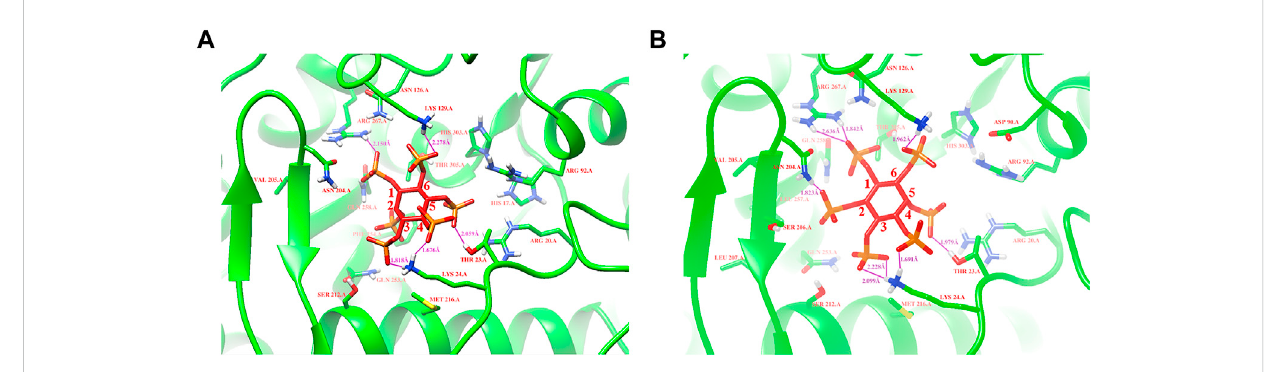
FIGURE 6 Modeling of parent and mutant F8 with phytate. (A) The binding position of phytate in the active-site cleft of parent; (B) The binding position of phytate in the active-site cleft of F8. Hydrogen bonds are represented by purple solid dash, substrate phytate is represented by a red stick.